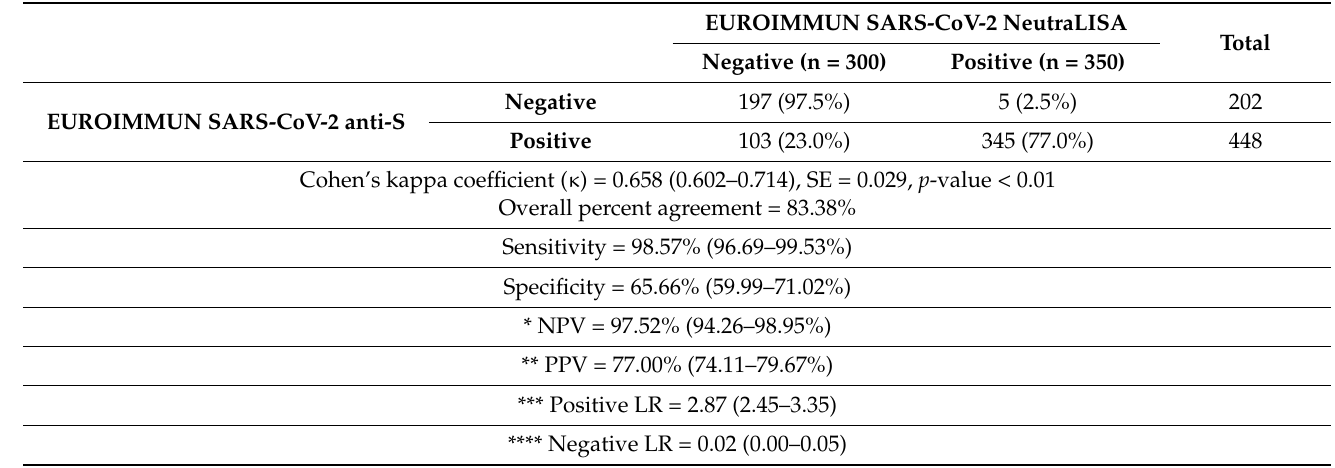
Table 2. Agreement and performance of EUROIMMUN SARS-CoV-2 anti-S with EUROIMMUN SARS-CoV-2 NeutraLISA as a gold standard (n = 650).